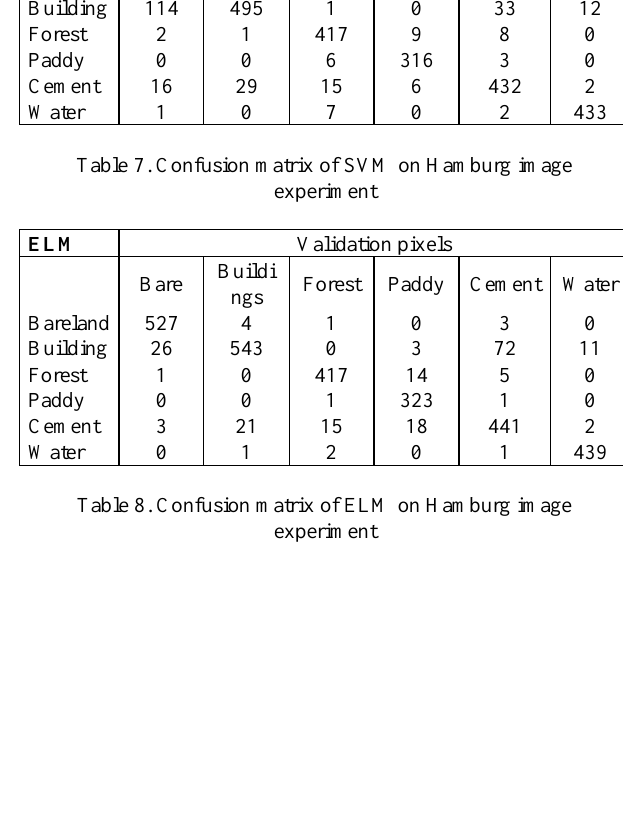
Table 5. Confusion matrix of A-optimal RELM on Wuhan